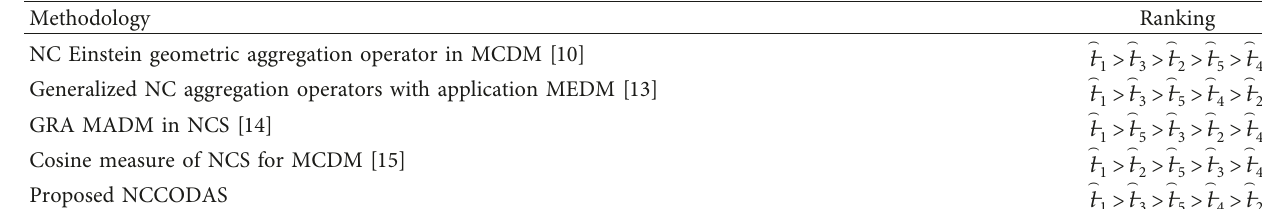
Step 6: calculation of assessment is tabulated in Table 4 by equation (20). Step 7: ranks of alternative in the ascending order are to get the desired alternative in Table 4. In Table 2, the data calculated in Steps 4–7 are tabulated for different values of q (Tables 6 and 7):